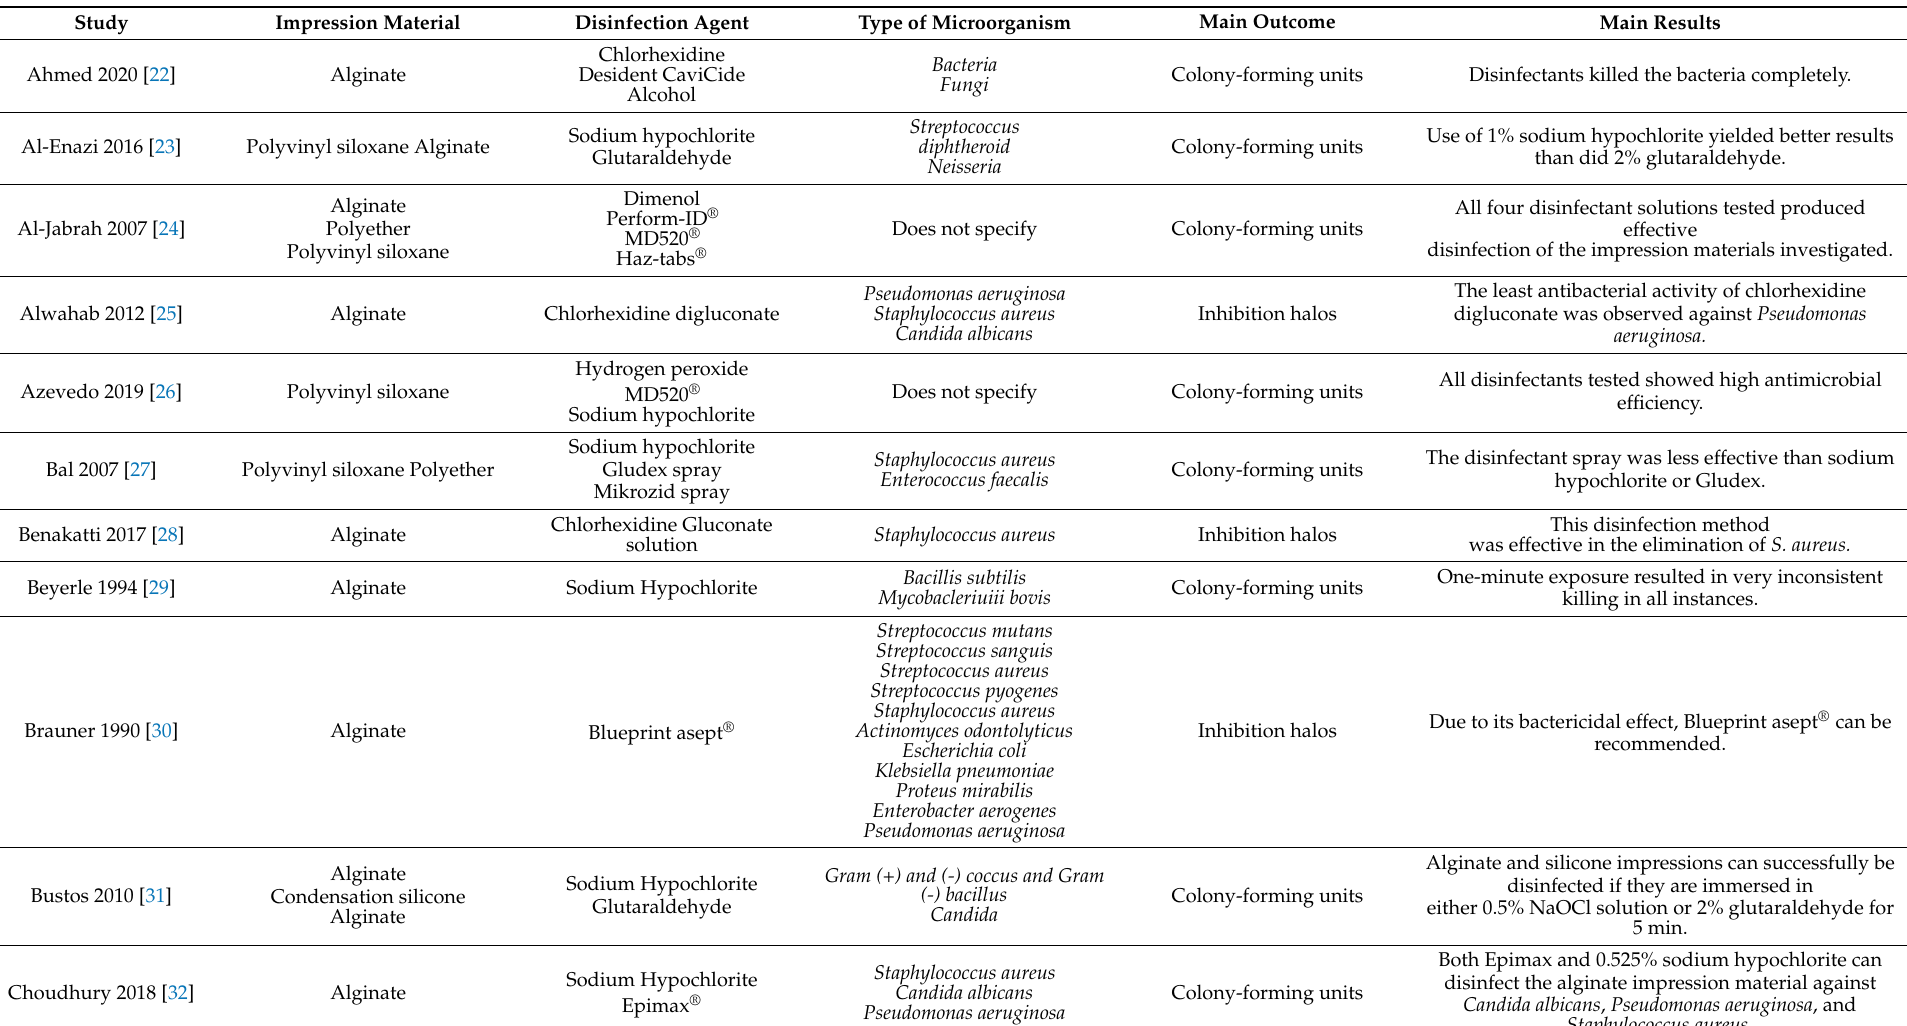
Table 2. Characteristics of the included